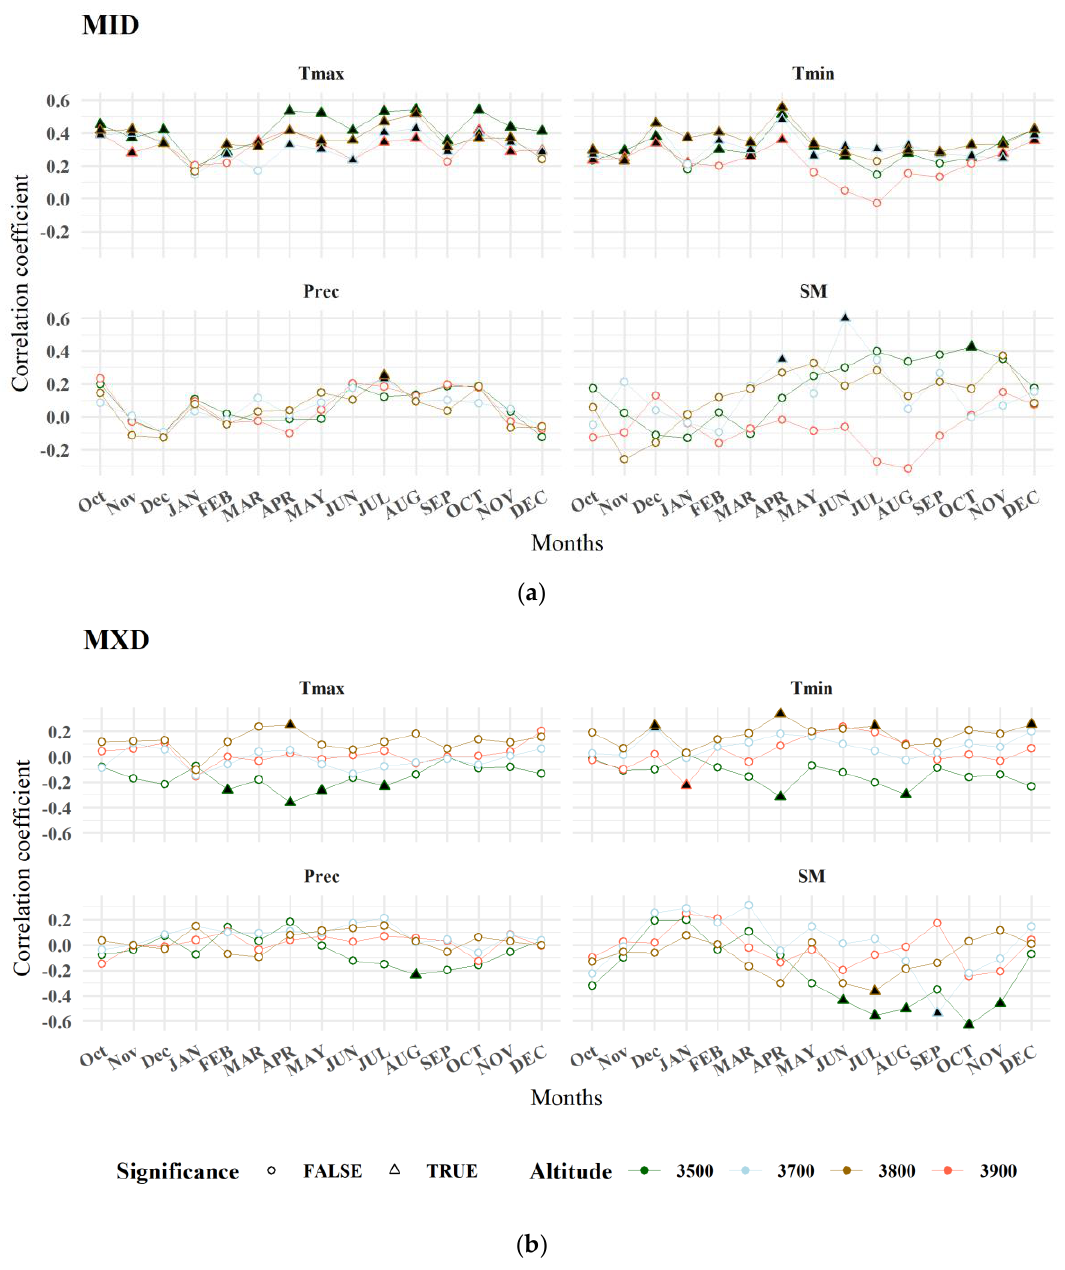
Figure 6. Correlations between ( a ) adjusted minimum earlywood density (MID) (upper panel) and ( b ) maximum latewood density (MXD) (bottom panel) and monthly climatic variables (Tmax—maximum temperature (°C), Tmin—minimum temperature (°C), Prec—precipitation (mm) and SM—Soil moisture (m 3 m −3 ) at two high-elevation forests (3500–3900 for Tláloc, and 3700–3800 for Jocotitlán). Significant correlations are indicated by triangles at the 0.01 significance level. Months of the previous year are indicated by lowercase letters while current is in uppercase letters.